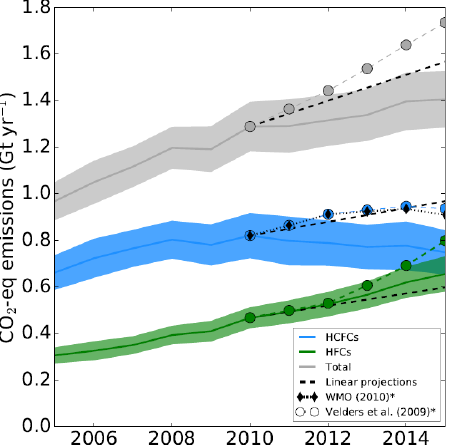
Figure 6. Aggregated HCFC and HFC emissions as CO 2 eq. (Gtyr − 1 ) solid blue and green lines, respectively; shading repre- sents 1 σ uncertainties. The grey line and shading represents the to- tal HCFC and HFC CO 2 eq. emissions. The thick black dashed line is a linear projection from 2010 to 2015, based on the 2005–2010 emissions growth rate. ∗ The thin dashed lines with the circular data points are the Velders et al. (2009) projection and the dashed line with the diamonds show the same but for HCFC emissions projec- tions (Montzka and Reimann, 2010). We have adjusted the start date of the Velders et al. (2009) emission trends to 2010 in alignment with the observationally derived